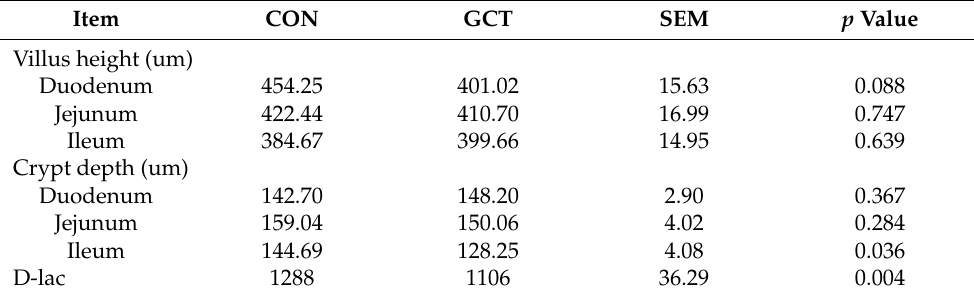
Table 5. Intestinal barrier and intestinal morphology of weaned piglets.